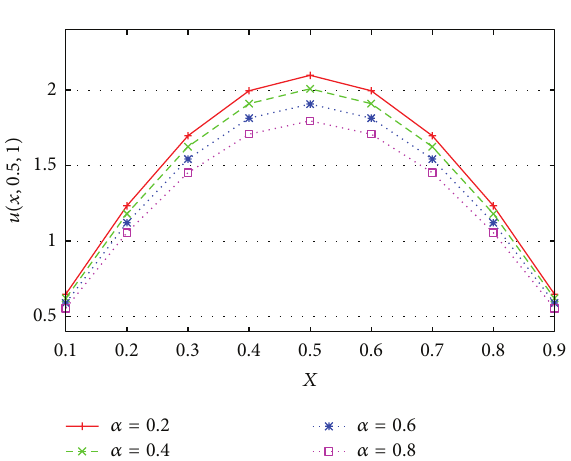
of four processes is 4.65 seconds. The speedup is 3.79. With 𝑁 = 512 , the runtime of one process is 4415.78 seconds and the runtime of four processes is 1394.99 seconds. The